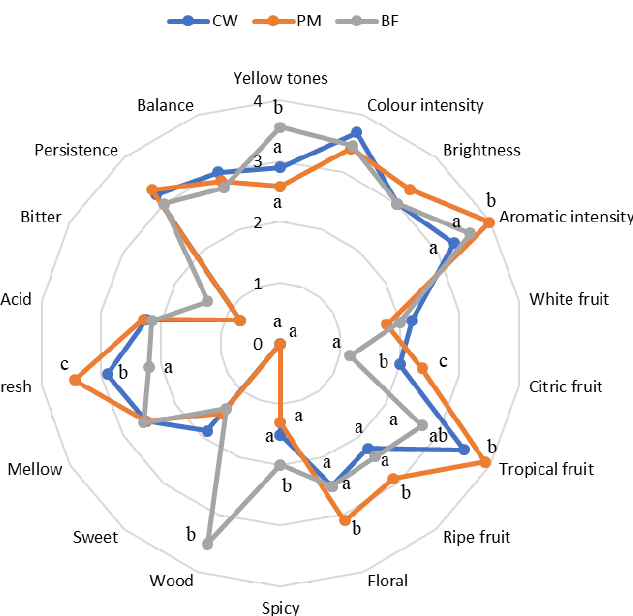
Figure 2. Sensory profile: visual, gustatory, and olfactory of Maturana Blanca wines produced by conventional winemaking (CW), conventional winemaking with pre-fermentative maceration (PM), and barrel fermentation (BF). Different letters indicate statistically significant differences ( p < 0.05) according to the Tukey HSD test ( n = 3).